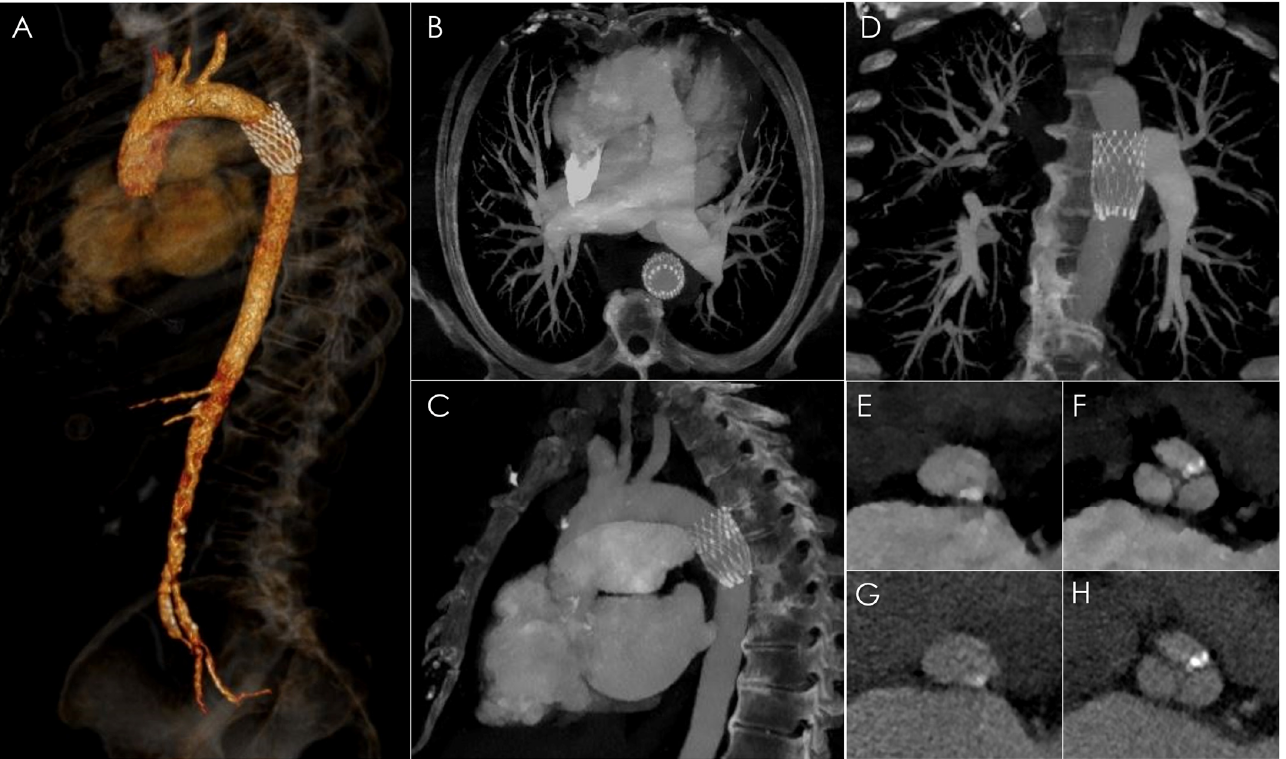
Figure 2. The patient was referred to our radiological department and underwent CTA on a dual- layer spectral CT scanner (IQon Spectral CT, Philips Healthcare, Best, The Netherlands) to rule out potential aortic complications, and to reassess the aortic valve annular size prior to a second TAVI procedure. A CT scan was performed in supine position, with acquisition of an ECG-synchronized dataset of the aortic root and heart followed by a CT Aortogram. The cumulative effective dose was 29 mSv. Fifty milliliters of iodinated contrast agent (Iomeron 400 mgI/mL, Bracco, Milan, Italy) was intravenously administered at a flow rate of 5 mL/s by antecubital access. Volumetric ( A ) and MIP ( B – D ) images based on 40 keV monoenergetic reconstructions (MonoE) allowed an increase in image quality by improving the contrast-to-noise ratio [3–9]. The images confirmed the dislocated prosthesis in the proximal descending thoracic aorta, but no aortic dissection, thrombosis or hematoma was present. MPR images along the aortic annulus and the sinus of Valsalva ( E–F ) allowed for a superior definition of anatomical sizing compared to the respective conventional images ( G–H ). The patient was indicated for a smaller valve prosthesis than the previous one.